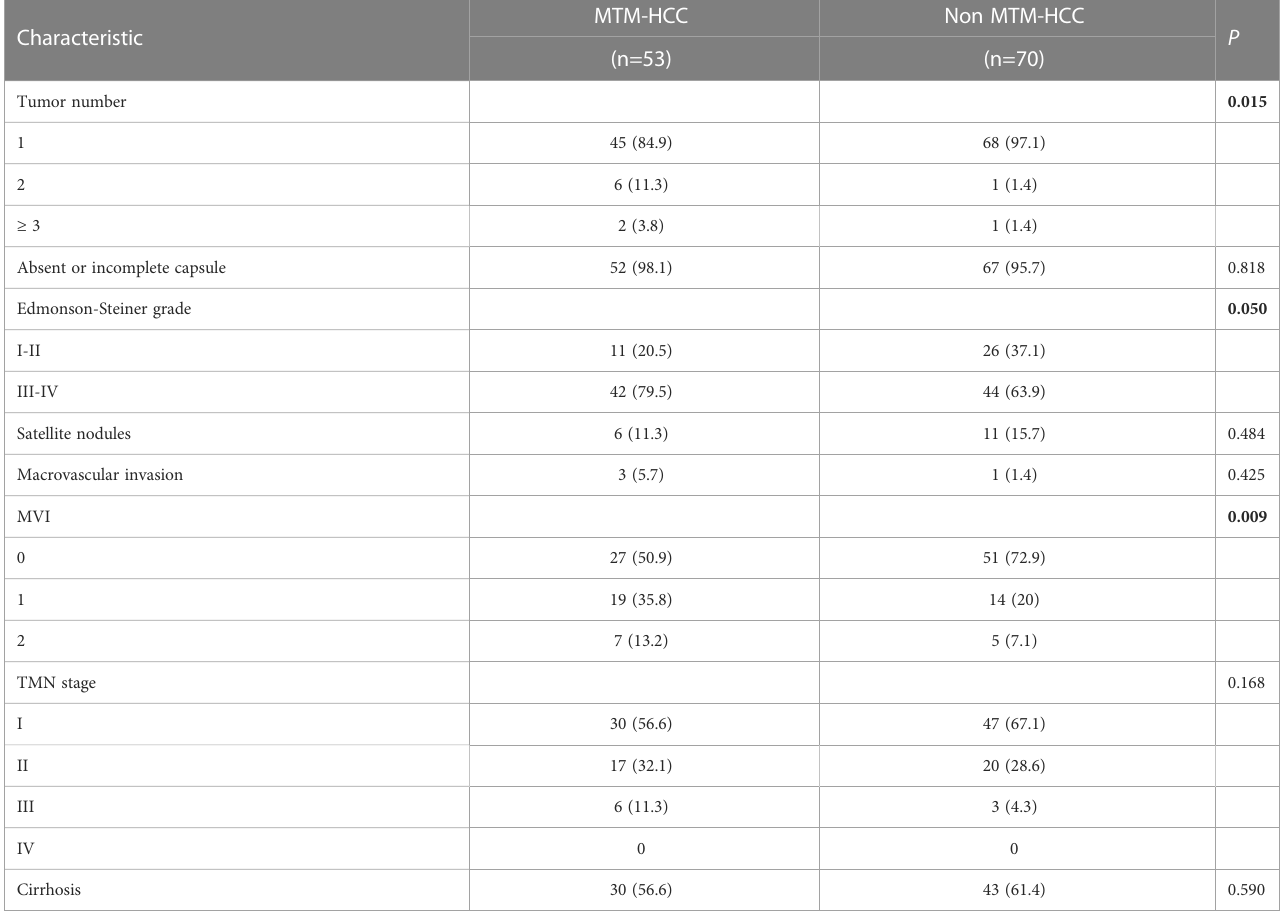
TABLE 2 Pathologic characteristics of patients with hepatocellular carcinoma in the primary cohort according to macrotrabecular-massive subtype.